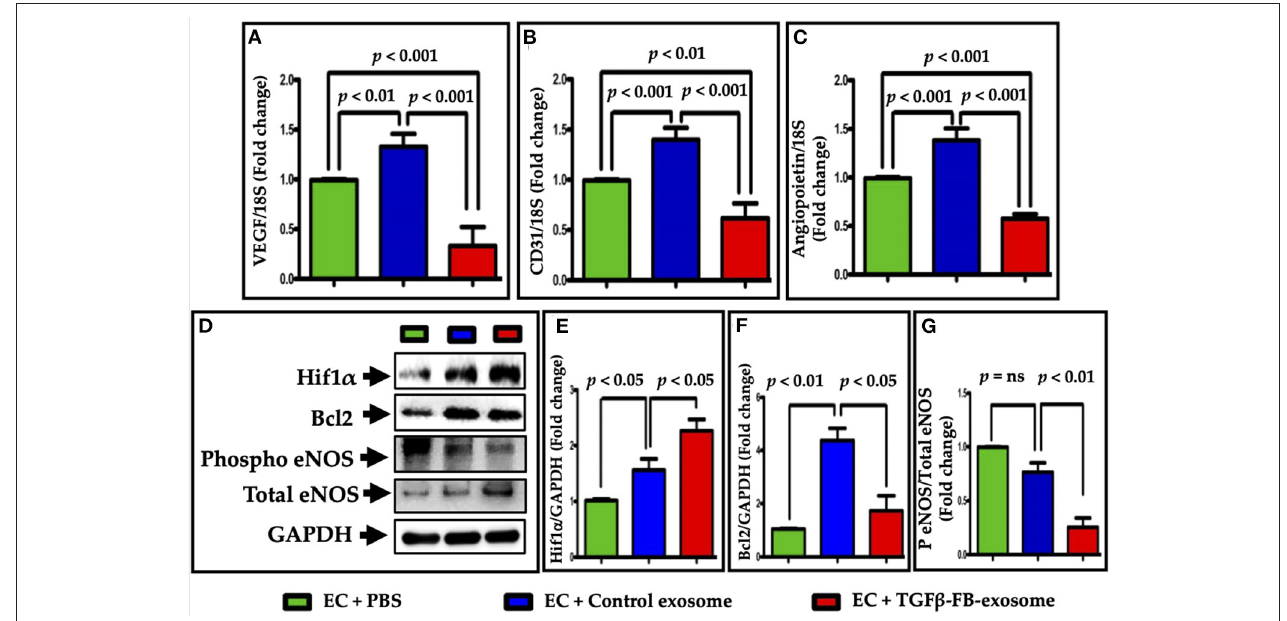
FIGURE 5 | Myofibroblast-derived exosomes impaired EC function-related genes and proteins expression. The mRNA expression of (A) VEGF-A, (B) CD31, and (C) angiopoietin1 were downregulated in the primary endothelial cells after treatment with TGF β -activated exosomes, as analyzed by real time qPCR. (D–G) Protein levels of HIF1 α , eNOS, and Bcl2 were measured. Expression of eNOS and Hif1 α were significantly altered by TGF β -FB-exosomes as compared to control exosomes, but in opposite manner. Bcl2 expression was also decreased in TGF β -FB-exosomes treated endothelial cells. P < 0.05 was considered as statistical